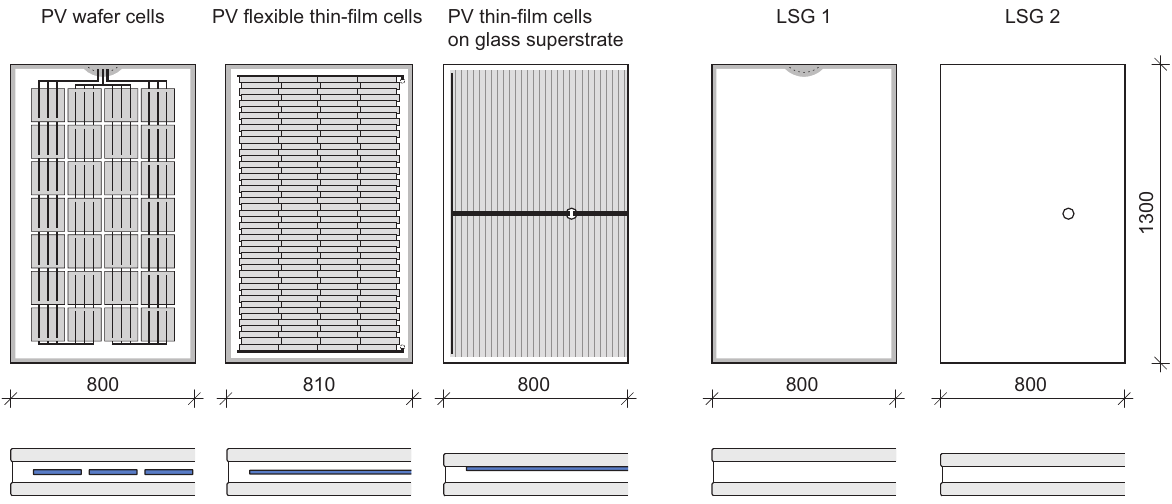
Fig. 10 View and section (not to scale) of PV module samples and laminated safety glass (LSG) references. PV superstrate module: back view. All others: front